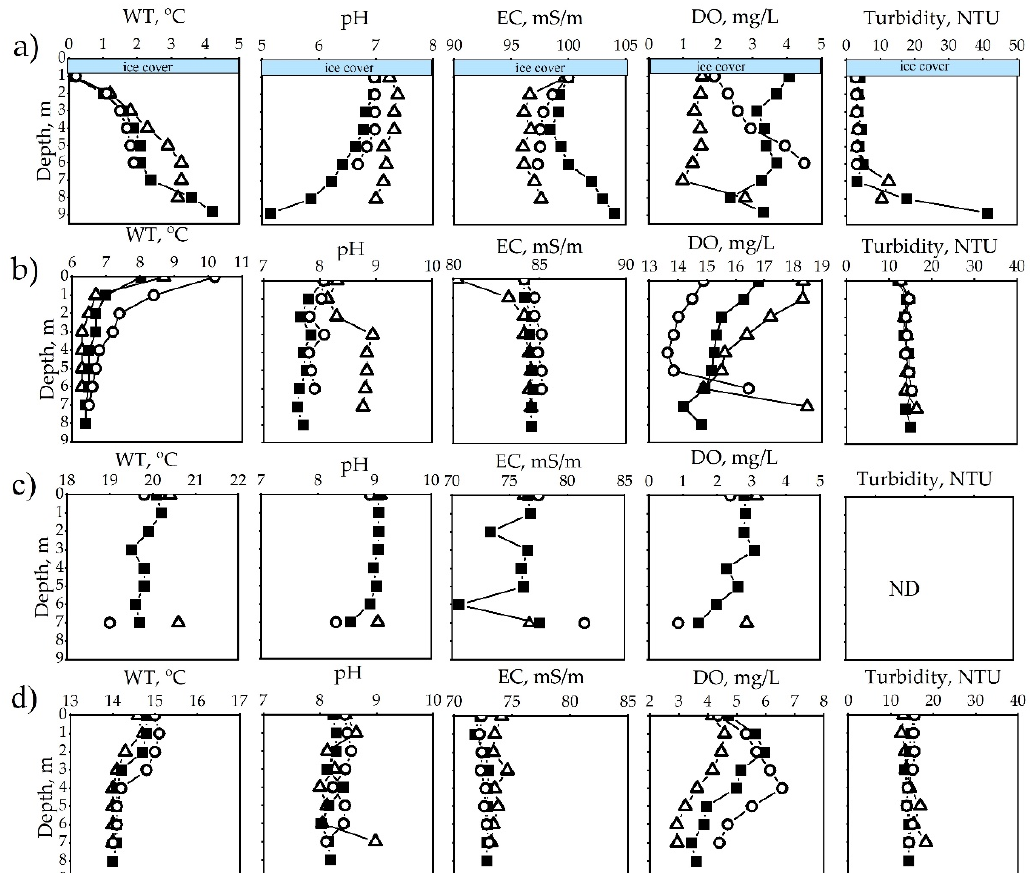
Figure 4. Vertical profiles of WQP of Lake Bulan. Note: ( a ) winter (25 February 2022), ( b ) spring (30 April 2022), ( c ) summer (27 August 2020), and ( d ) autumn (26 September 2021); WT—water temperature, EC—electrical conductivity, DO—dissolved oxygen, NTU—nephelometric turbidity unit; open triangle—Bulan 1, closed square—Bulan 2, open circle—Bulan 3; ND—no data.